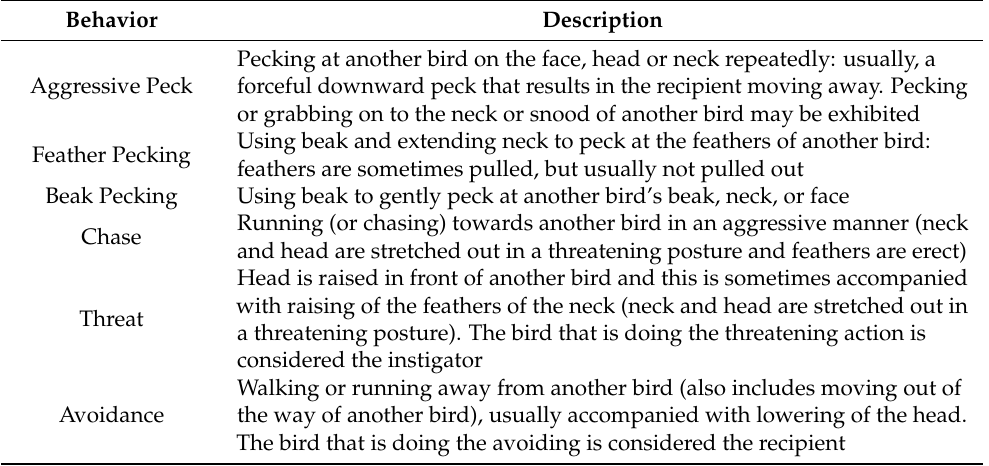
Table 6. Ethogram of turkey behavior observed continuously for 15 min at 1300 and 1600 h two days before the treatments were